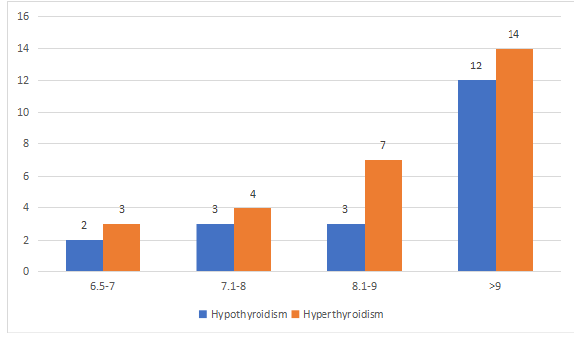
Figure 1. Thyroid dysfunction based on glycaemic